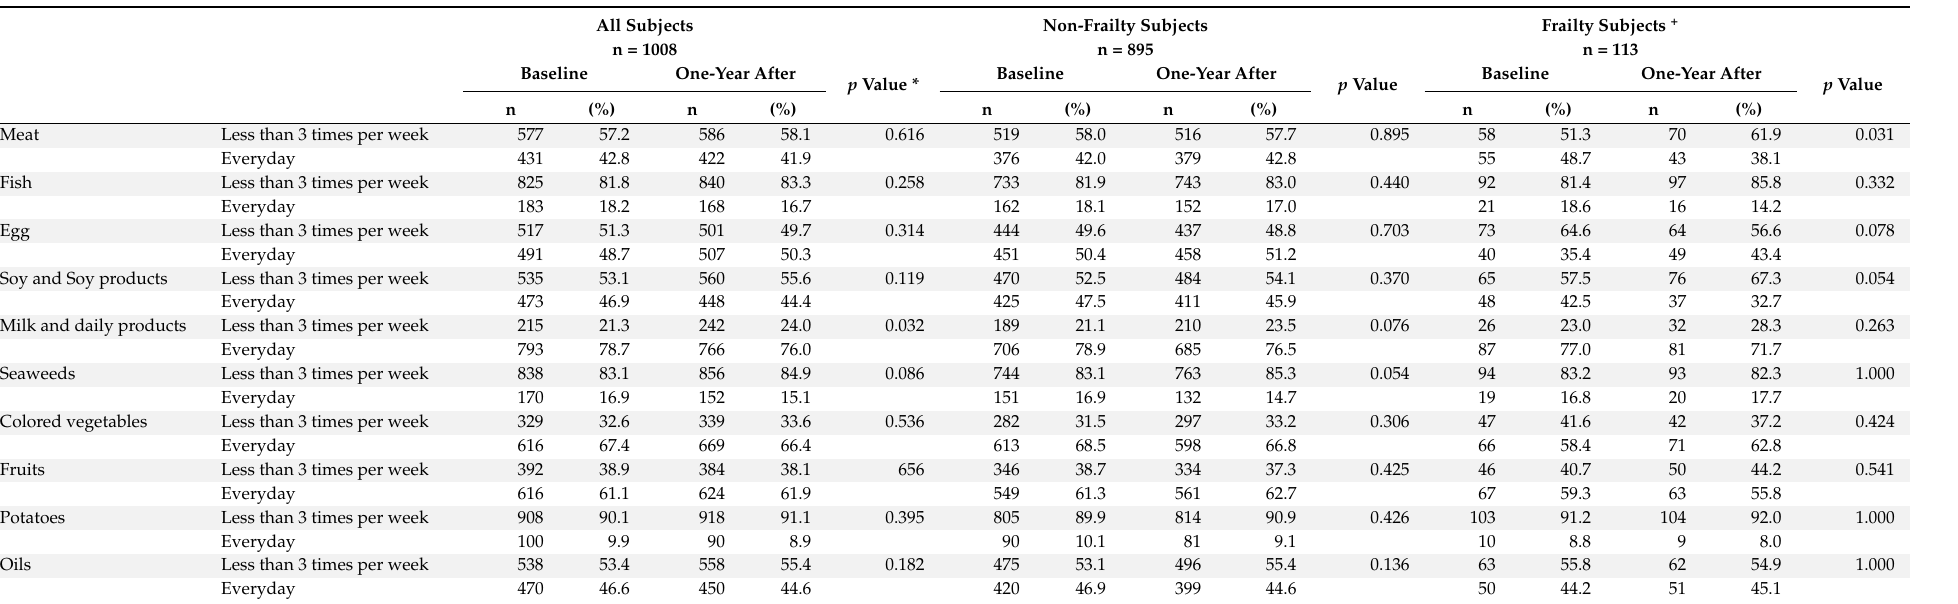
Table 2. Changes in dietary variety during one-year follow-up survey